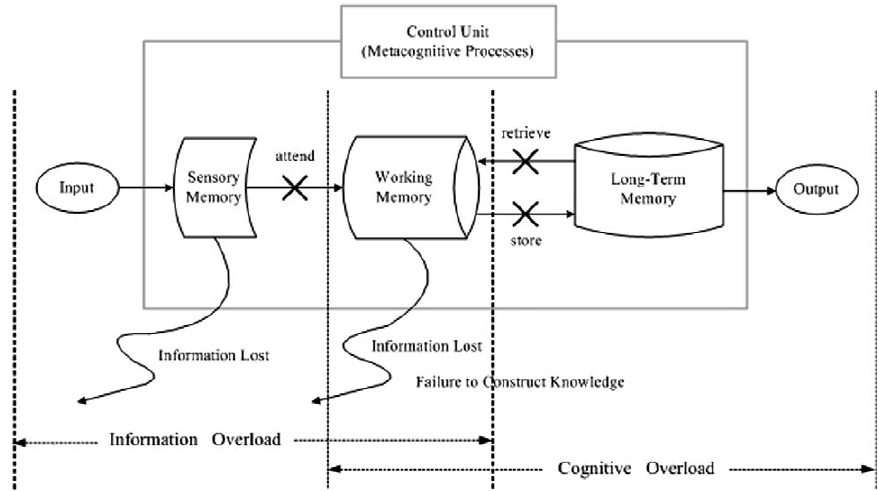
Figure 2. Information overload vs. cognitive